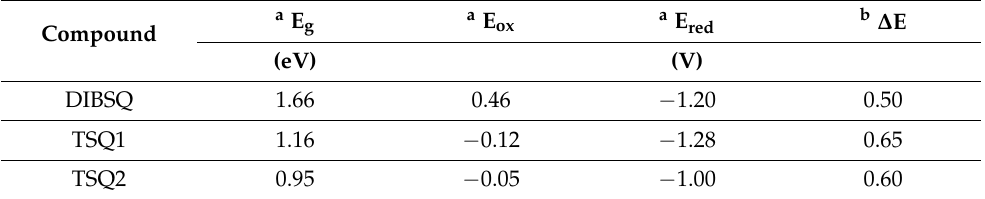
a E a E a E g ox red (eV) (V)